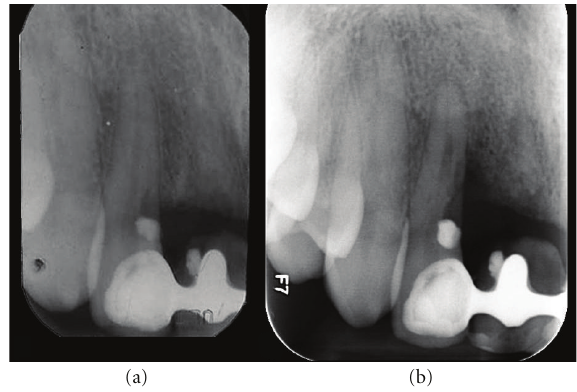
Figure 6: Patient 1: radiographs of the right maxillary central incisor region. (a) 2000. The radiograph demonstrates a filling in the mesial aspect of the lateral incisor and resorption below this filling. The alveolar bone level has not changed remarkably since the situation demonstrated in Figure 4(d). (b) 2012. The radiograph demonstrates severe bone loss of the alveolar bone mesially to the lateral incisor root. The resorption process below the filling has progressed.